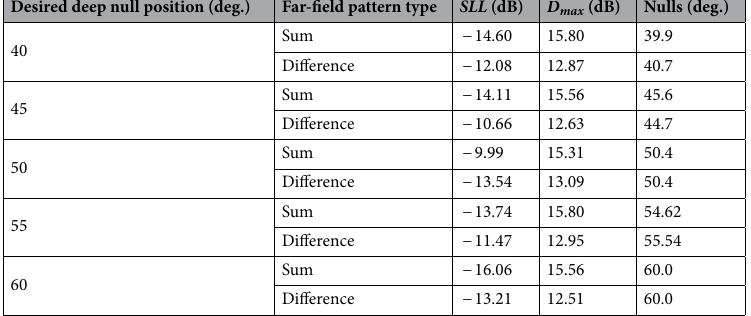
Table 2. Results of the optimization of a linear array of 40 elements with common relative excitations for generating both sum and difference patterns, improving SLL, peak directivity ( D max ) and including a desired common deep null.